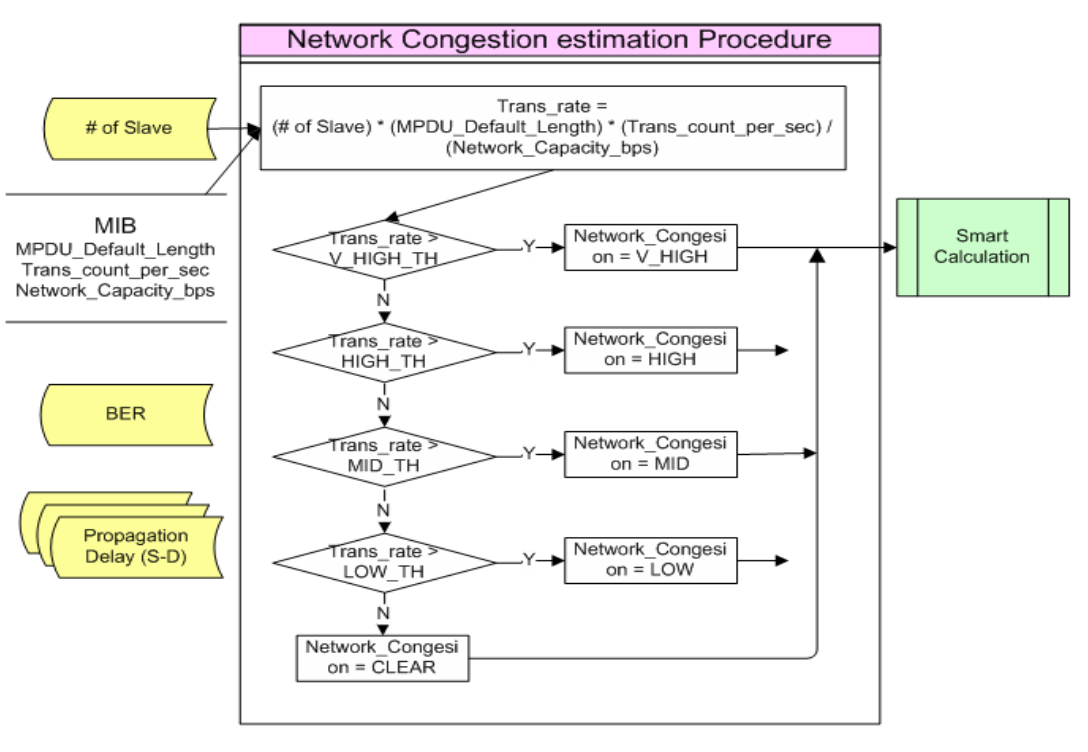
Figure 5. Network Congestion estimation